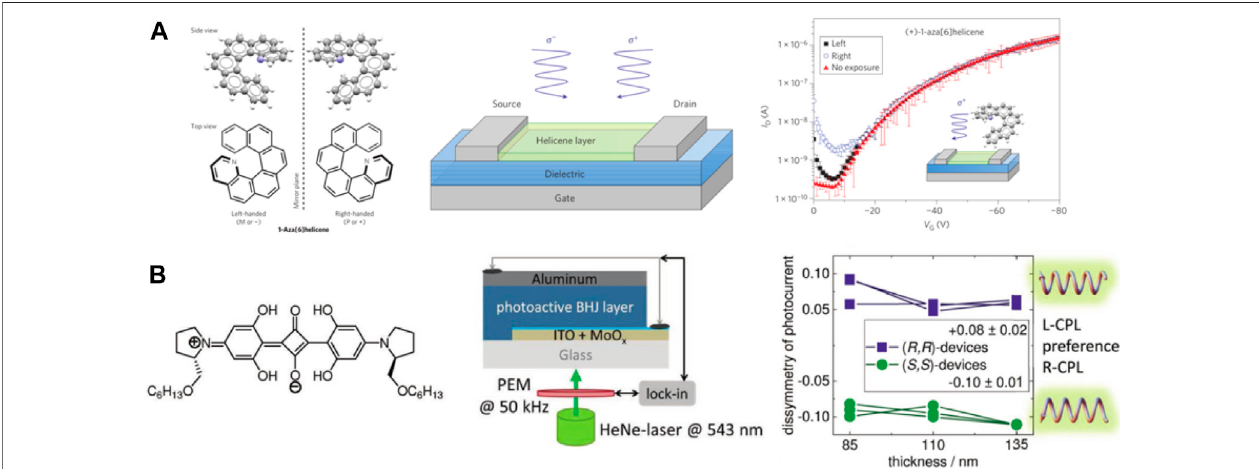
FIGURE 3 | (A) Molecular structure of (+)-1-aza[6]helicene, device structure of the CPL phototransistors, and transfer characteristic curve of the phototransistors based on (+)-1-aza[6]helicene in the dark or under CPL illumination ( λ (cid:1) 365 nm, power (cid:1) 10 mW cm 2 ) (Yang et al., 2013b). Reproduced with permission. Copyright 2013,NaturePublishingGroup. (B) ChemicalstructureofProSQ-C6,aschematicdiagramofthedevicearchitecture,anddissymmetryofshort-circuitcurrentg lsc under illumination with 543 nm CPL (Schulz et al., 2019). Reproduced with permission. Copyright 2019,